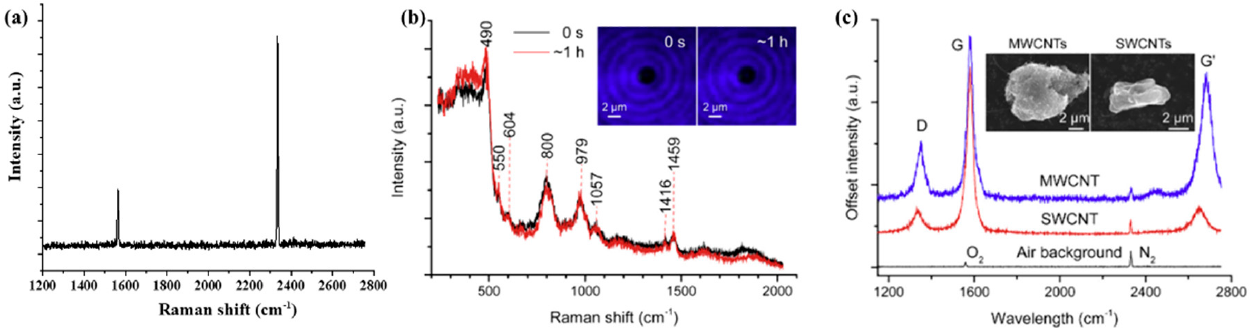
Figure 2. ( a ) Raman spectra of oxygen and nitrogen in ambient lab air, (Reproduced with permission from [8]. Copyright 2021, IOP science). ( b ) Raman spectra of single, trapped SM, ( c ) Raman spectra of single, trapped SWCNT and MWCNT. (Reproduced with permission from ref. [36]. Copyright 2018, Elsevier).